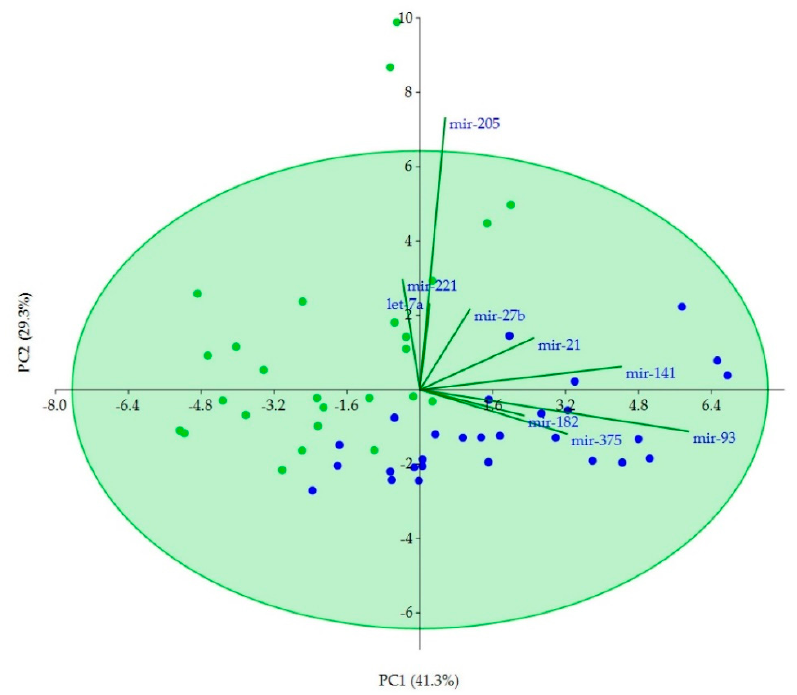
Figure 3. Principal component analysis (PCA) plot on miRNAs expression data from PCa (green dots) and NT (blue dots) tissue samples using the first two components.